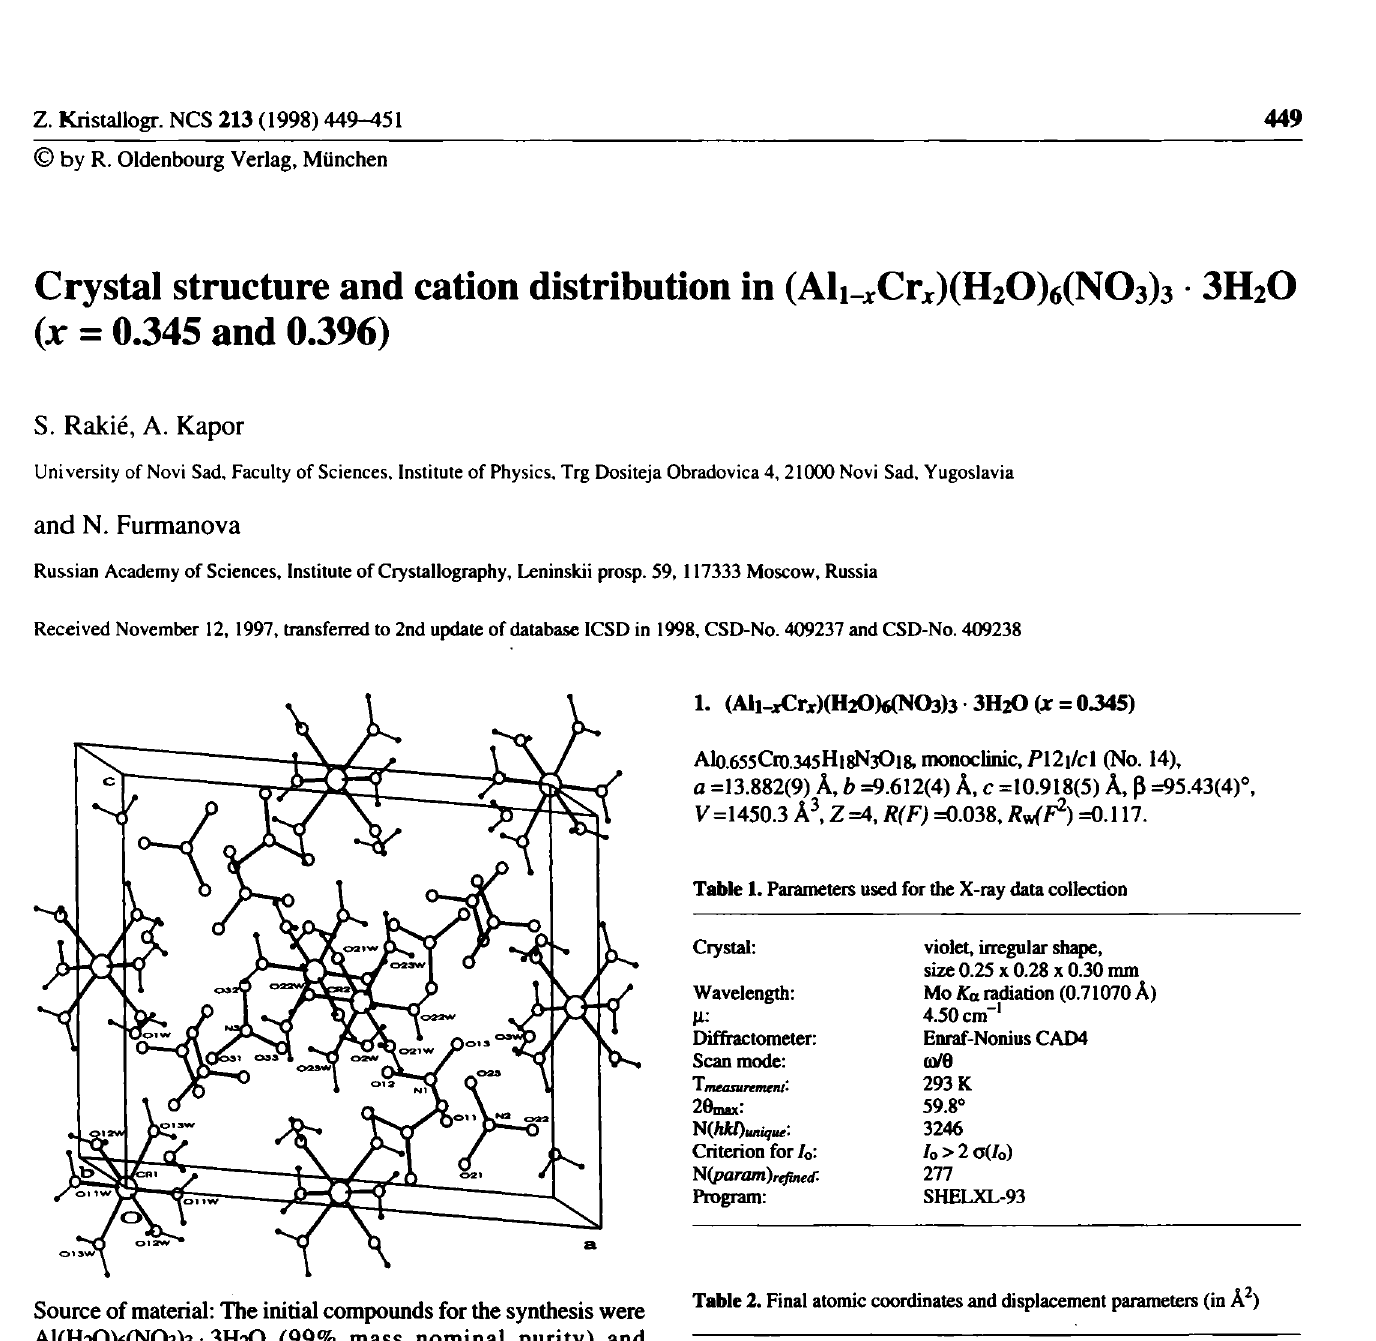
Table 2. Final atomic coordinates and displacement parameters (in